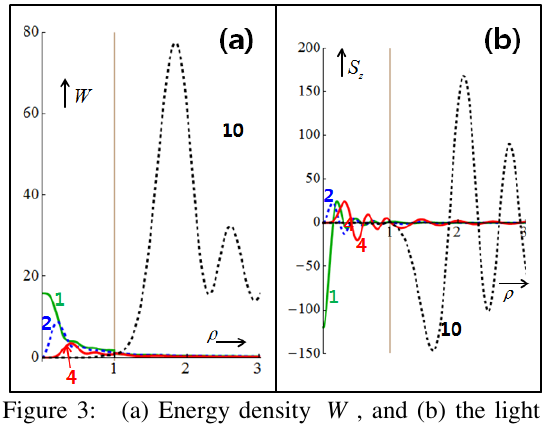
Figure 3: (a) Energy density W , and (b) the light S over the range 0 3 ρ ≤ ≤ for varying spin z 1,2,4,10 m = . On each panel, four curves are generated for 1,2,4,10 m = in different colors. Respective curves are presented such that ( ) 1 1 ex W ρ = = and ( ) 1 1 ex S ρ = = on the exterior z side of the material interface located at 1 ρ = . A solid cylinder with 2 1 in ex n n = > = is under 2 q π = as a common